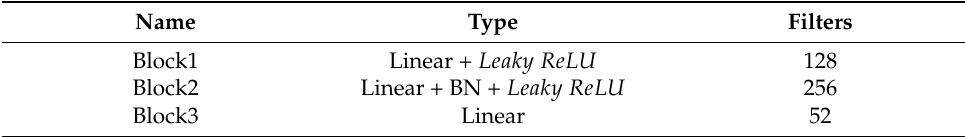
Table 2. Details of the decoder network.